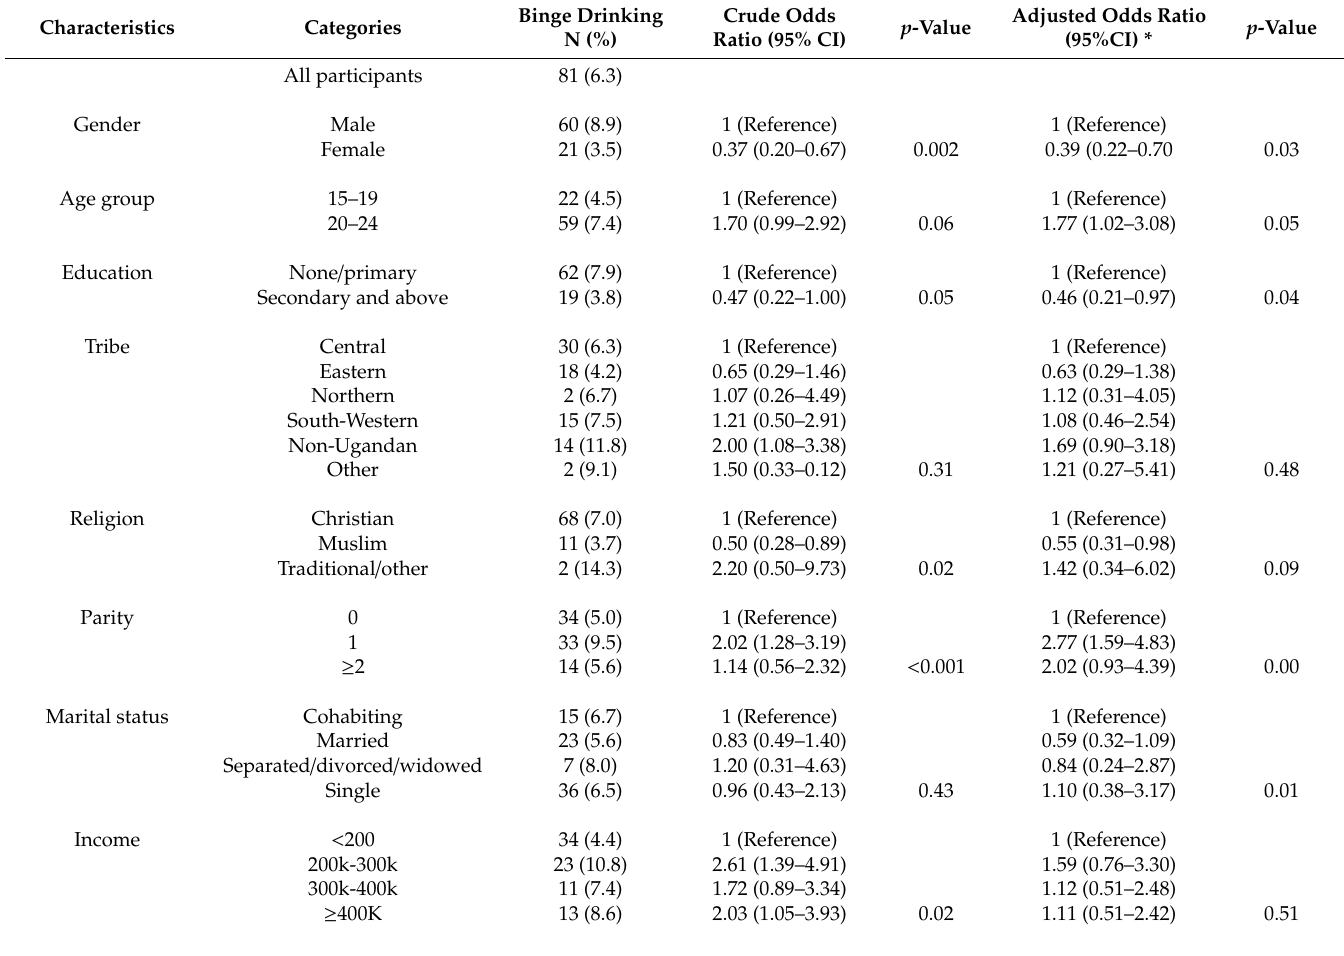
Table 4. Risk factors for alcohol misuse (binge drinking in previous month) among young people aged 15–24 years in fishing communities in